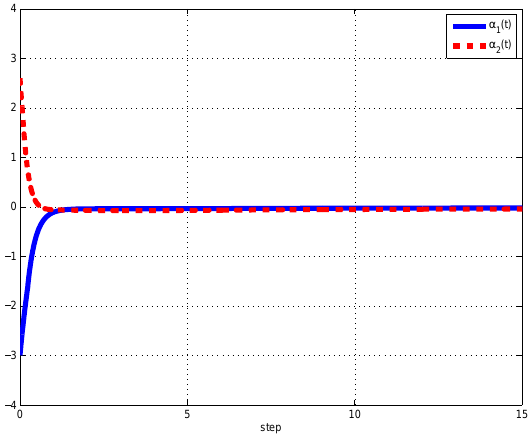
Figure 1. The error state trajectory of r i ( t ) and ˜ r j ( t ) .